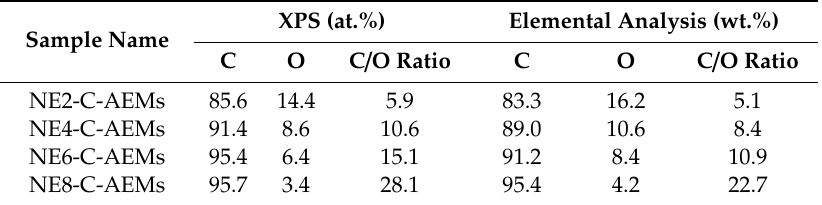
Table 2. Chemical structure of NE-C-AEMs characterized by XPS and elemental